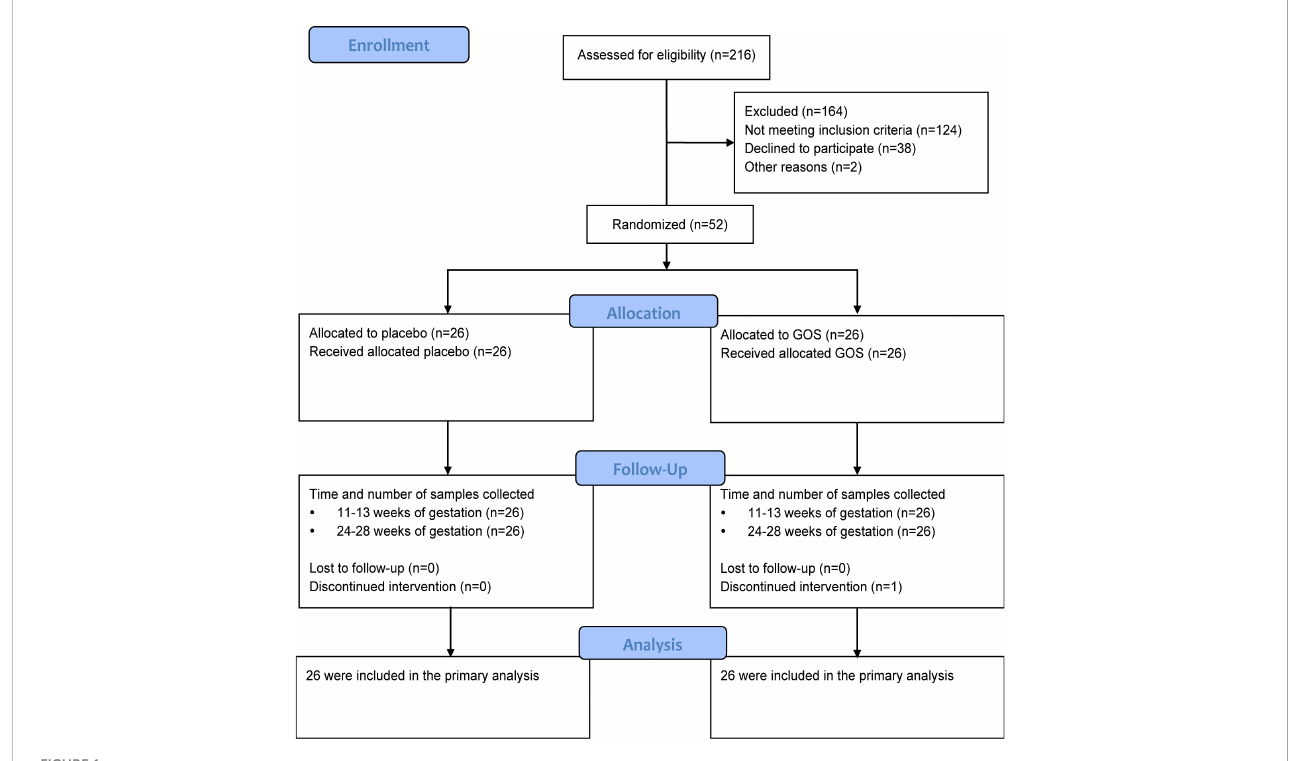
FIGURE 1 Flow chart of participants through the